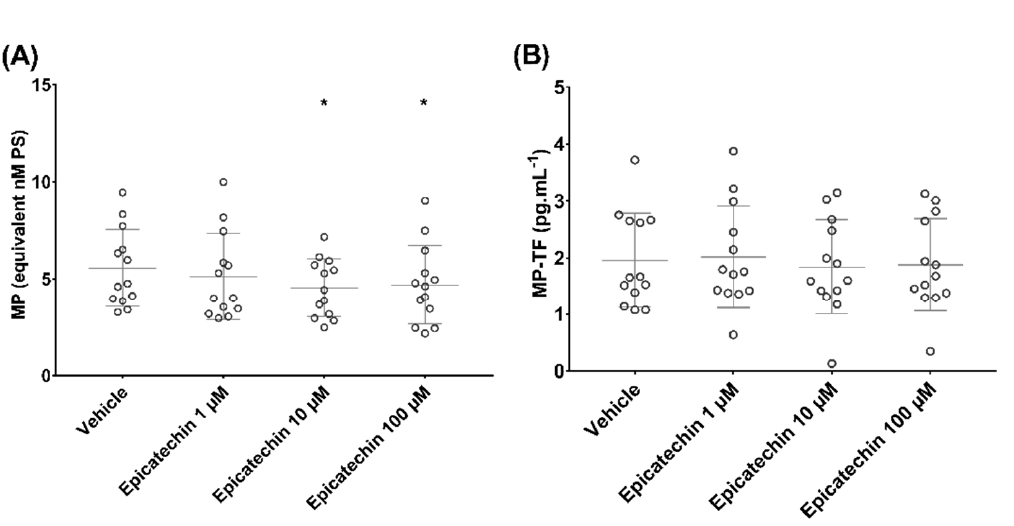
Figure 3. Effect of epicatechin on the concentration of microparticles (MPs) that express ( A ) phosphatidylserine (PS) and ( B ) tissue factor (TF). * Significant effect of intensity. No impact of epicatechin on TF-positive microparticle concentration (pg/mL) was observed when the procoagulant activity was induced by TF and assessed using the Zymuphen TM MP-TF kit: 2.0 ± 0.8 in samples incubated with vehicle, and 2.0 ± 0.9 ( p = 0.9), 1.8 ± 0.8 ( p = 0.9) and 1.9 ± 0.8 ( p = 0.9) in samples incubated with 1, 10 and 100 μ M epicatechin, respectively (Figure 3B). Epicatechin influenced TGA performed with MRP as source of phospholipids and TF. ETP (nM.min) decreased from 586 ± 302 in samples incubated with vehicle to 509 ± 226 ( p = 0.3), 512 ± 270 ( p = 0.3) and 445 ± 283 ( p < 0.05) in samples incubated with 1, 10 and 100 μ M epicatechin, respectively (Figure 4A). Thrombin peak (nM) also decreased from 9 ± 6 in samples incubated with vehicle to 7 ± 5 ( p = 0.2), 7 ± 5 ( p = 0.4) and 6 ± 5 ( p < 0.05) in samples incubated with 1, 10 or 100 μ M epicatechin, respectively (Figure 4B). Thrombin activation kinetics tended to change, but not significantly. Specifically, lag time and time to peak ranged from 40.2 ± 19.5 and 69 ± 32 in samples incubated with vehicle to 53.1 ± 25.2 and 88 ± 38 in samples incubated with 100 μ M epicatechin, respectively.